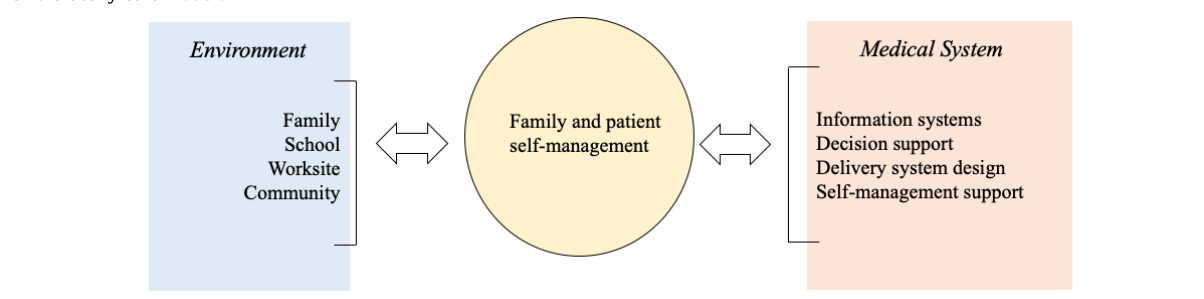
Figure 2. Obesity care